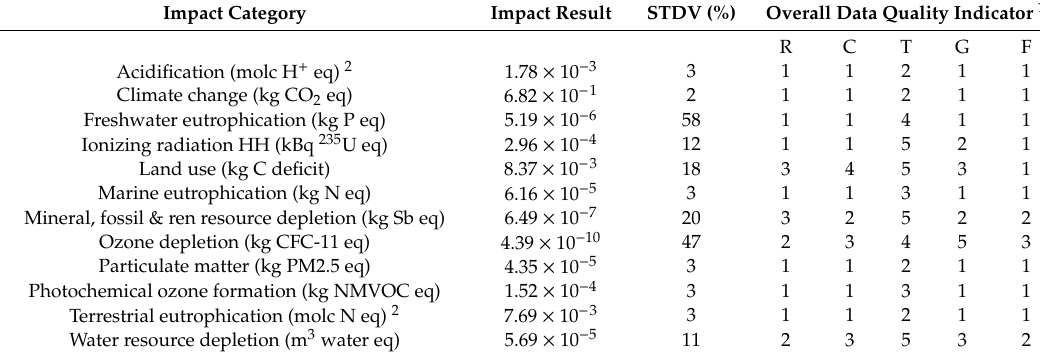
Table 9. Uncertainty analysis for each impact category results and data quality indicator score. (R) Reliability; (C) Completeness; (T) Temporal correlation; (G) Geographical correlation; (F) Further technological correlation.